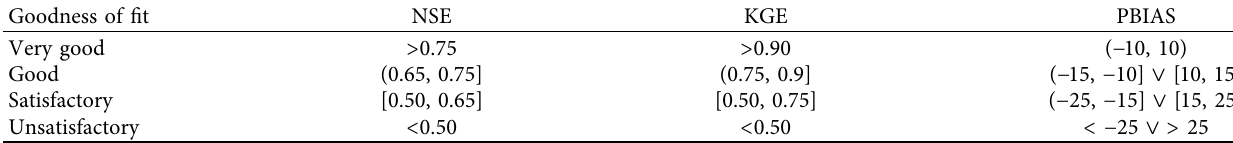
Table 2: Classification of the goodness of fit and